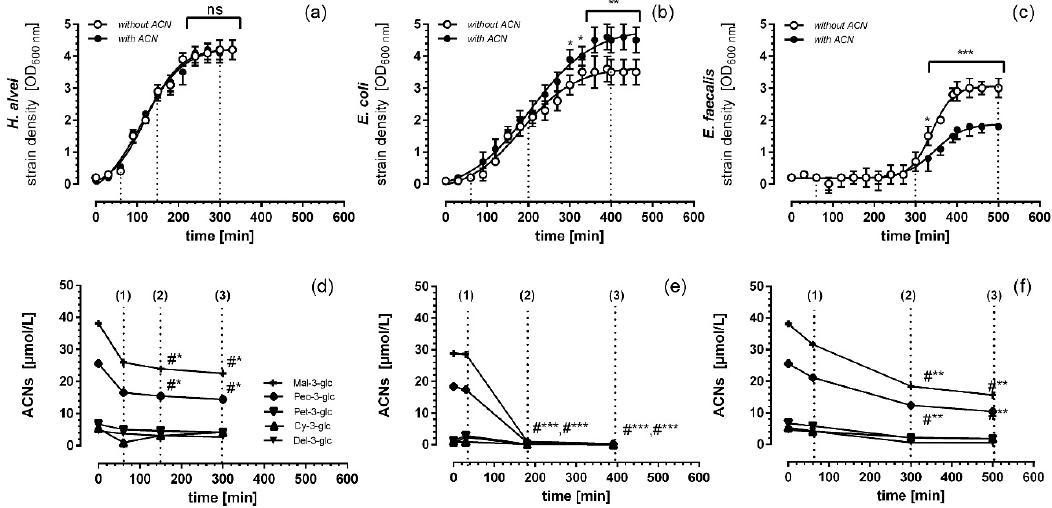
Figure 2. MO growth kinetics of H. alvei ( a ) E. coli ( b ) and E. faecalis ( c ) with or without ACNs in culture media. MO growth media were supplemented with 50 µ mol/L malvidin-3-glucoside (Mal-3-glc) equivalents of an ACN-rich grape/berry extract or remained non-supplemented. The growth of the MOs was monitored spectrophotometrically (OD 600 nm) and was plotted over time (min). At different time points (lag-phase (1), log-phase (2) and stat-phase (3)), MO suspensions with and without ACNs were taken and ACNs in the culture media of H. alvei , E. coli and E. faecalis were determined as described in the Materials and Methods ( d – f ). Values are given as the means ± SEM ( n = 3, each done in duplicate). Differences between growth kinetics with and without ACNs, as well as between ACN fermentation and the initial ACN concentration in the growth media were significant at * p < 0.05, ** p < 0.01 and *** p < 0.005 and #* p < 0.05, #** p < 0.01 and #*** p < 0.005, respectively.